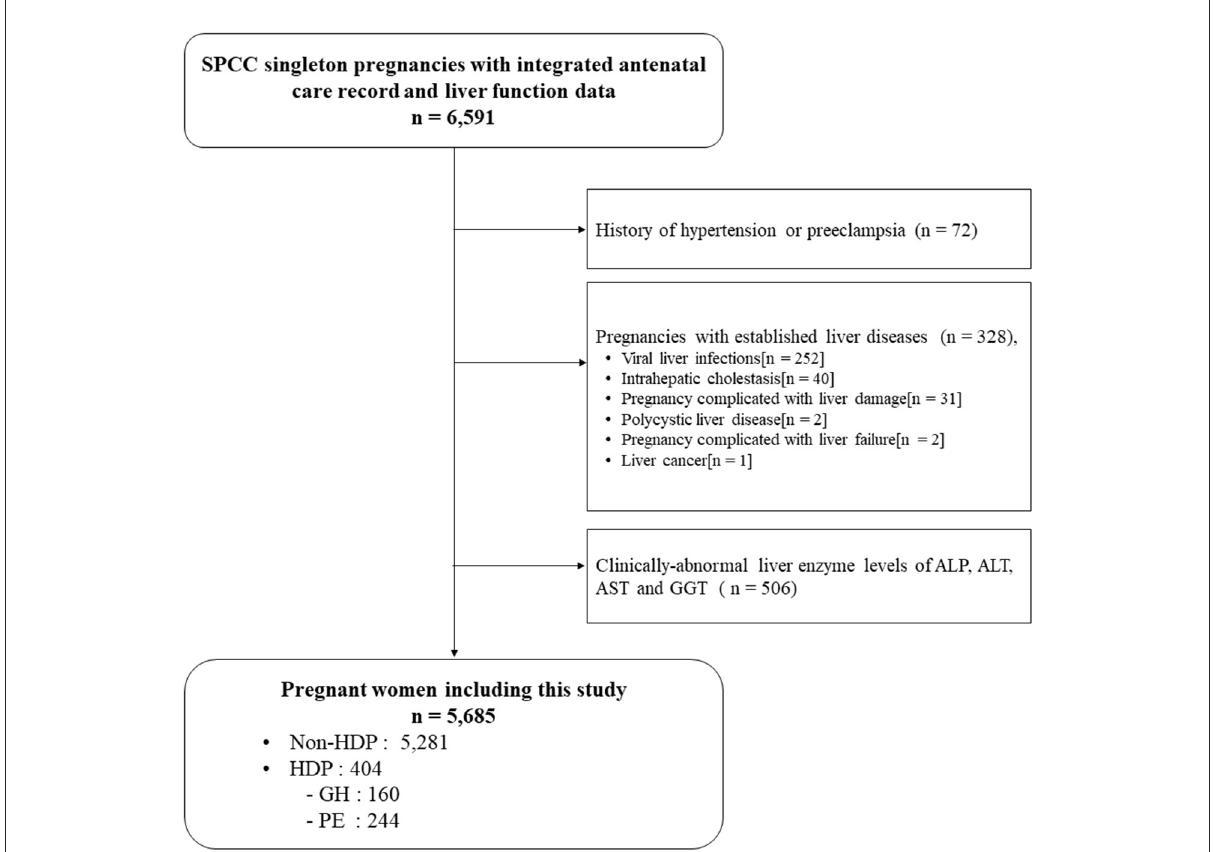
FIGURE1 Flow chart of participants. HDP, hypertensive disorders of pregnancy; GH, Gestational hypertension; PE,